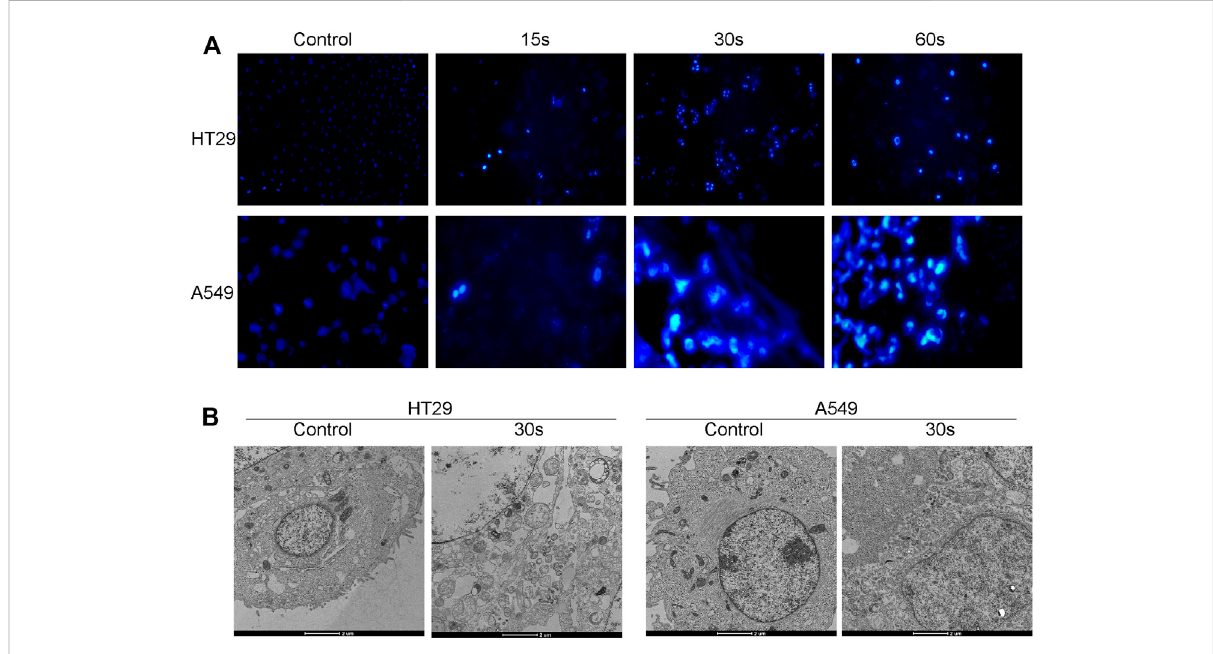
FIGURE 4 Qualitative analysis of the HT29 and A549 cellular apoptosis upon CAP PZ2 treatment. (A) Fluorescent microscopic images of nuclear changes (e.g., chromatin condensation) in the HT29 and A549 cells stained with Hoechst33342. (B) Transmission electron microscopic images of ultrathin sections (x10,000) demonstrating subcellular changes in the HT29 and A549 cells treated with CAP PZ2 for 30 s. All images are at the same magni fi